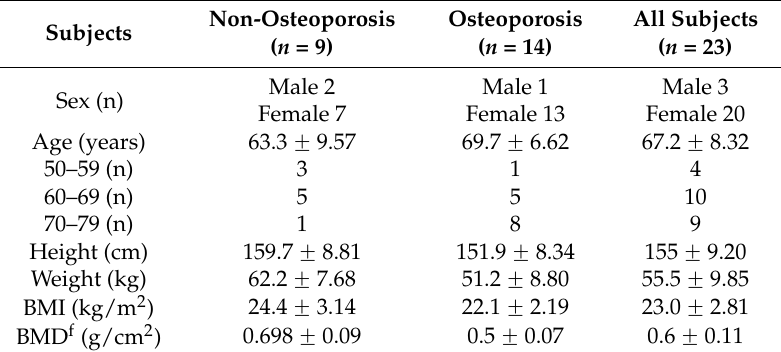
Table 1. Demographic data of the